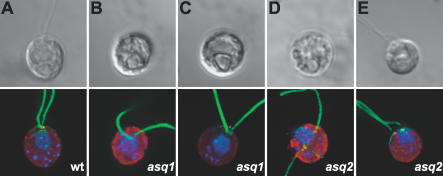

asq Mutants Can Be Divided into Two Classes Based on the Pairwise Distribution of CentriolesImages of fixed cells stained with DAPI and antibodies against centrin and acetylated tubulin (green) and Bld10p (red). DIC images are shown in the top panels, and fluorescence images of the same cells are shown below. All images are positioned so that the pyrenoid is located at the bottom.(A) wt cells have two centrioles located together at the apical side of the cell. One pro-centriole can be seen in the foreground of this image (red, marked by antibodies recognizing Bld10p). The other pro-centriole is occluded from view by the centriolar pair.(B and C) asq1 cells have two centrioles that are positioned together at random locations on the cell surface.(D) In asq2 cells, centrioles can be found at locations independent of one another. In this cell, both centrioles appear to be mispositioned.(E) In this asq2 cell, one centriole along with its pro-centriole (marked by Bld10p staining in red) is found at the correct apical location. Another mispositioned centriole is found on the left, shifted off the long axis.